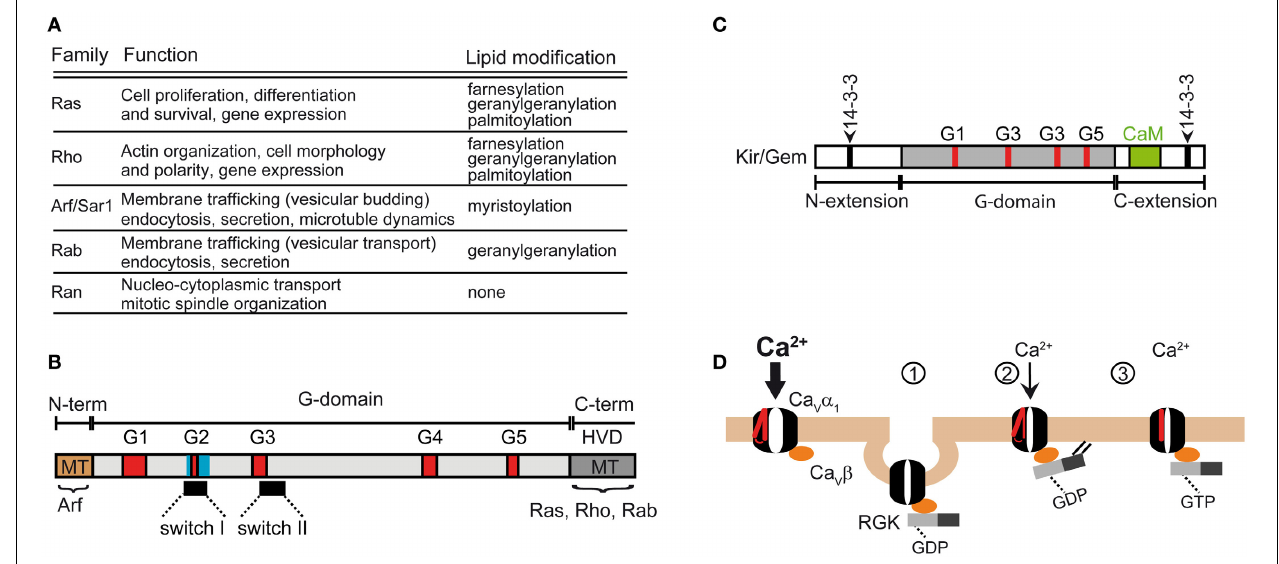
contain two sites for 14-3-3 binding. The β -subunit of calcium channels binds to the G-box. (D) Models explaining RGK induced reduction of Ca 2 + currents mediated by HVA channels (described in Yang et al., 2010). The normal function of HVAs requires the association of the β -subunit. Channel activation is preceded by the movement of the voltage sensor, represented in red. RGKs bound to GDP associate with the β -subunit and downregulate the channel by promoting its backward trafficking through a dynamin-dependent endocytosis (1) or by decreasing its open probability through a mechanism that relies on RGK membrane anchoring (2). Gating of the channel may be also altered by GTP-bound RGK through immobilization of the voltage sensor